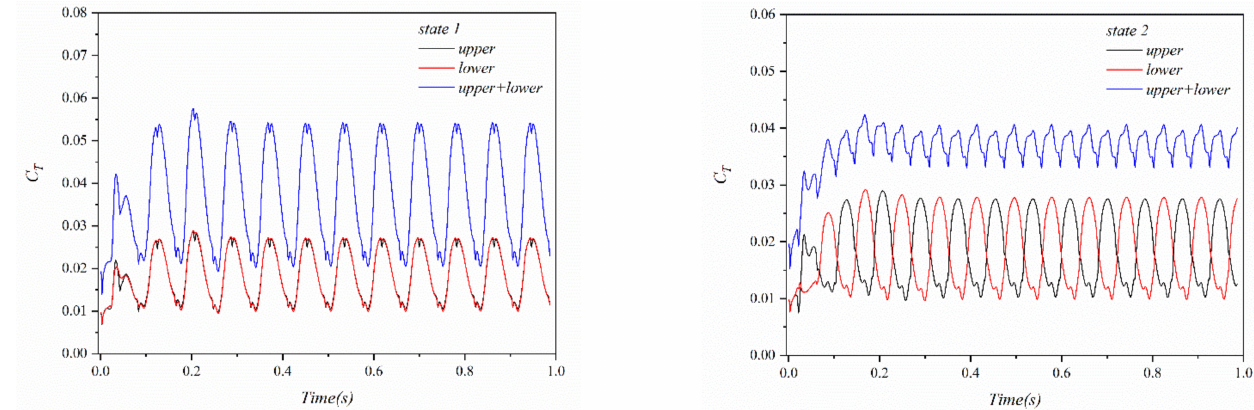
Figure 16. The isolated rotor C T of the upper and lower rotors in forward